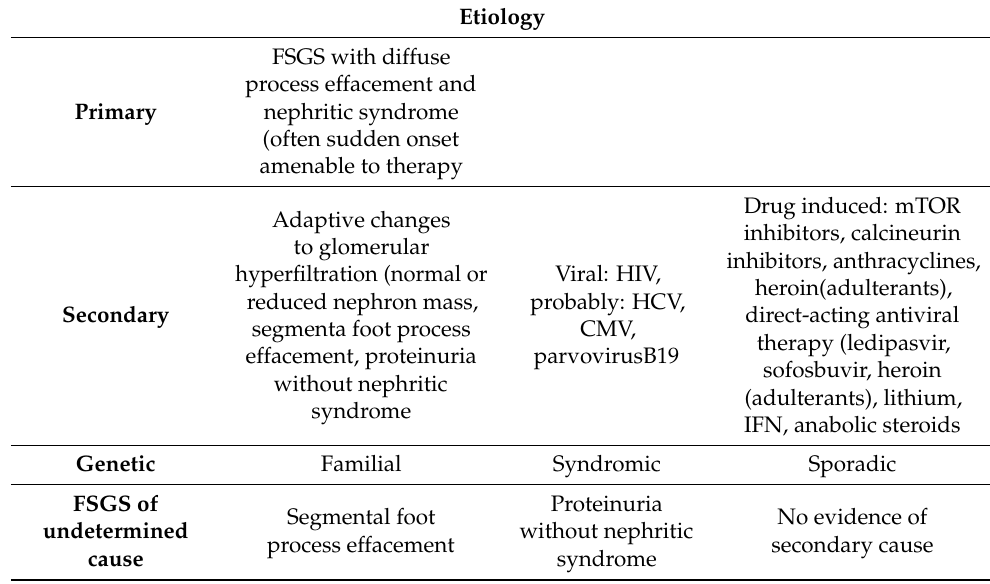
Table 2. The KDIGO classification of